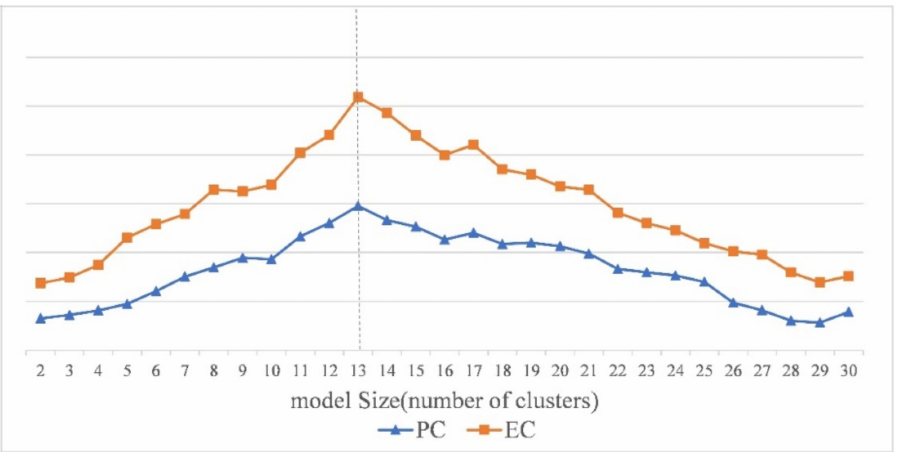
Figure 7. Trends of PC and EC indexes on linguistics research topics in the dataset of